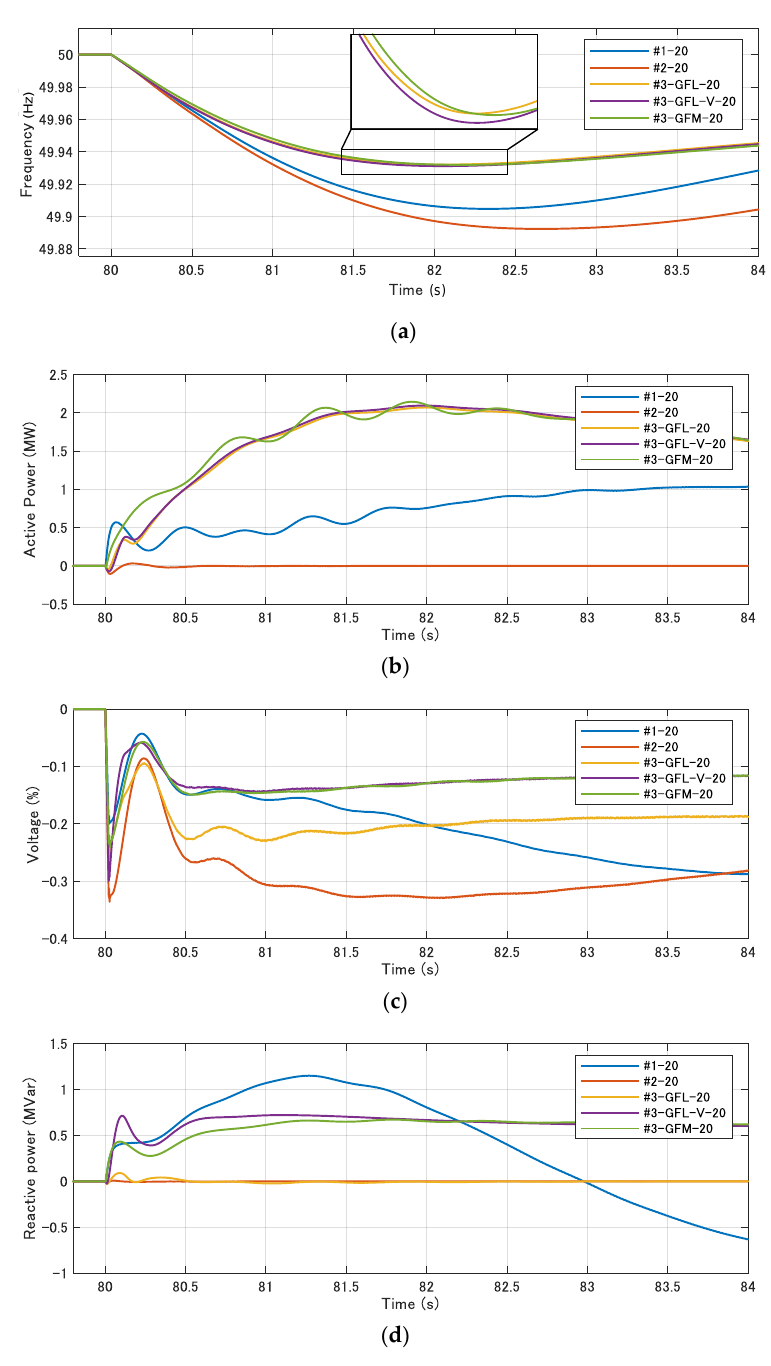
Figure 9. Simulation result of the cases for the 20% IBR penetration rate (disturbance was a 5-MW generation loss). ( a ) COI frequency, ( b ) the deviation of the active power output of S3, ( c ) the deviation of the voltage at the POI of the IBR, and ( d ) the deviation of the reactive power output of S3.